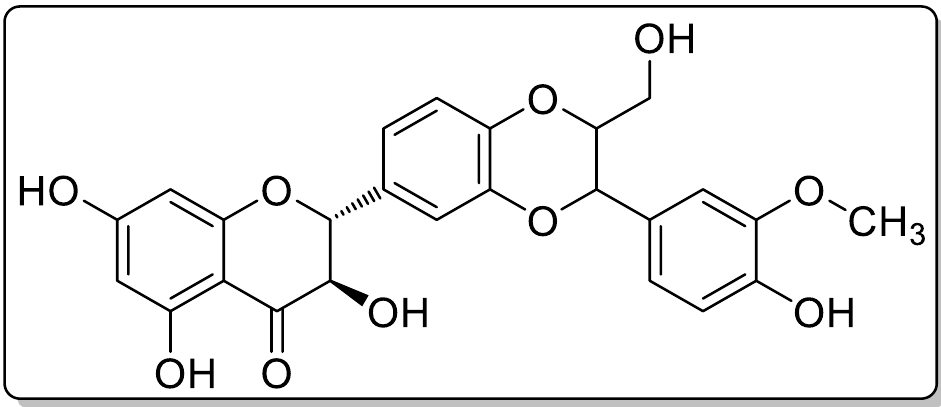
Figure 1. Chemical structure of silymarin flavonolignan.